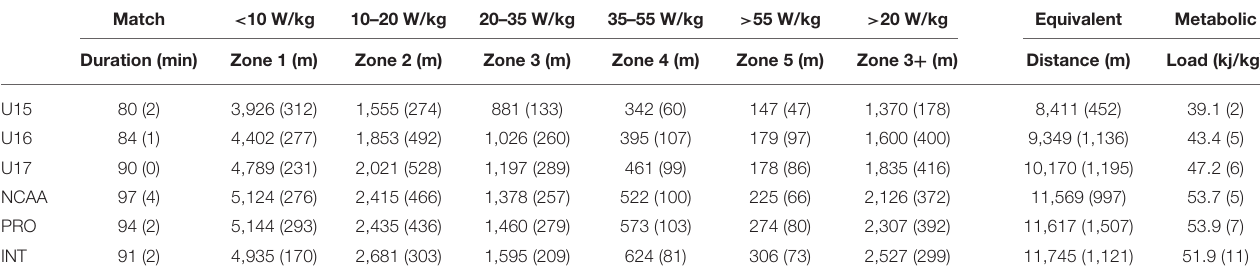
TABLE 4 | Metabolic power distances and load across